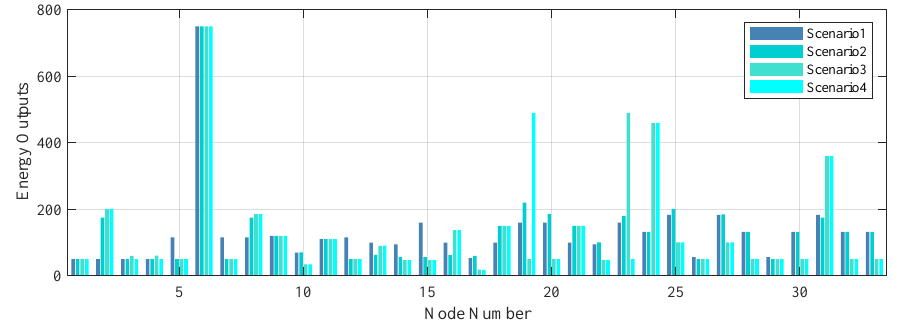
Figure 5. Energy outputs of 33